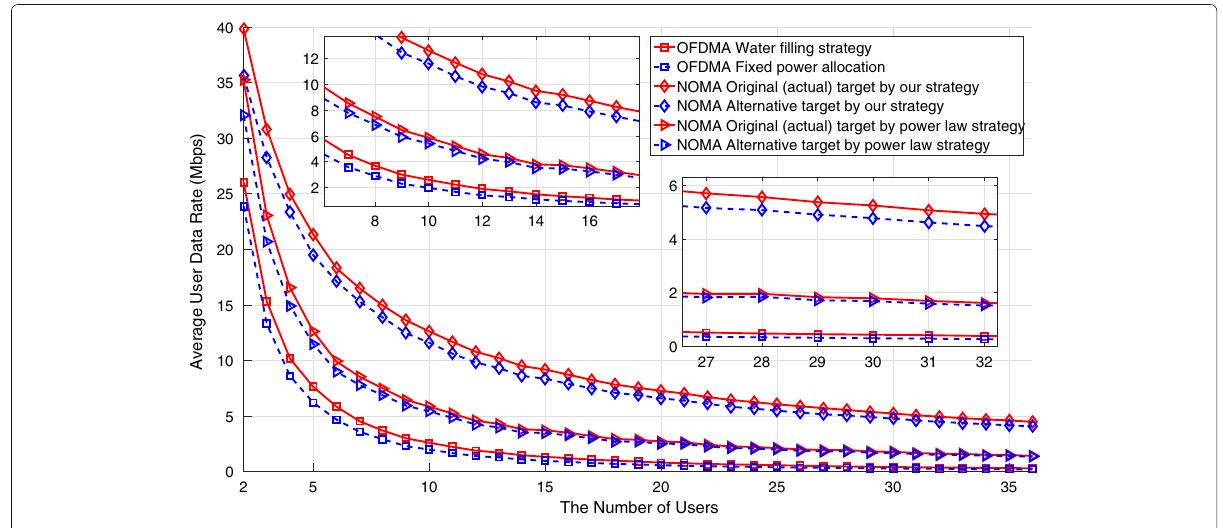
Fig. 4 The AUDR comparison among multi-access methods with (cid:5) 1 / 2 = (cid:6) FOV = 60°